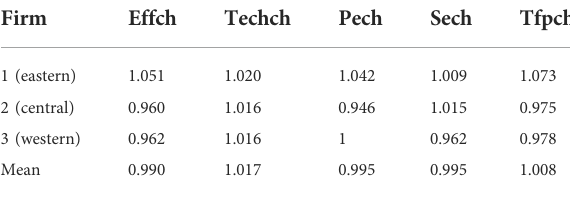
Firm Effch Techch Pech Sech